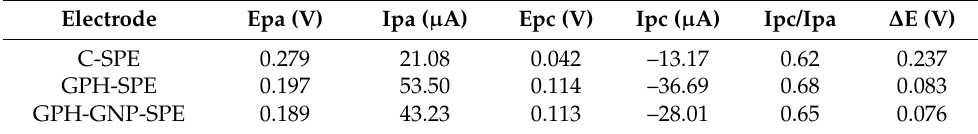
Table 3. The values of the parameters obtained from the CVs of all the electrodes immersed in 10 − 3 M CGA solution (the electrolyte support was 10 − 1 M PBS of pH = 7).